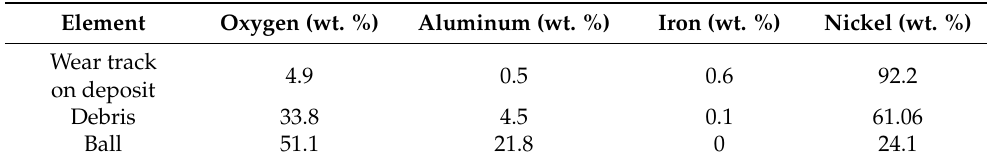
Table 7. Chemical composition of the wear track on the heat-treated deposit, debris, and the ball after the dry ball-on-flat sliding